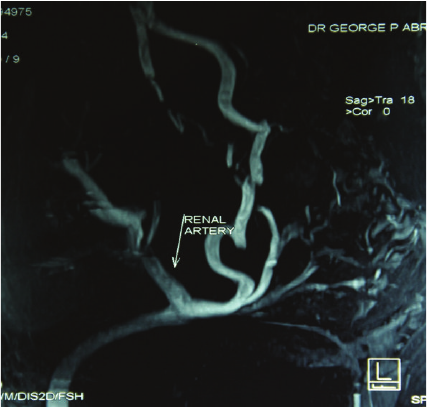
Figure 3: A MR angiogram done 6 weeks later revealed good vascular supply to the transplanted kidneys and the right lower limb. An absent or hypoplastic iliac system on the right side could as well be